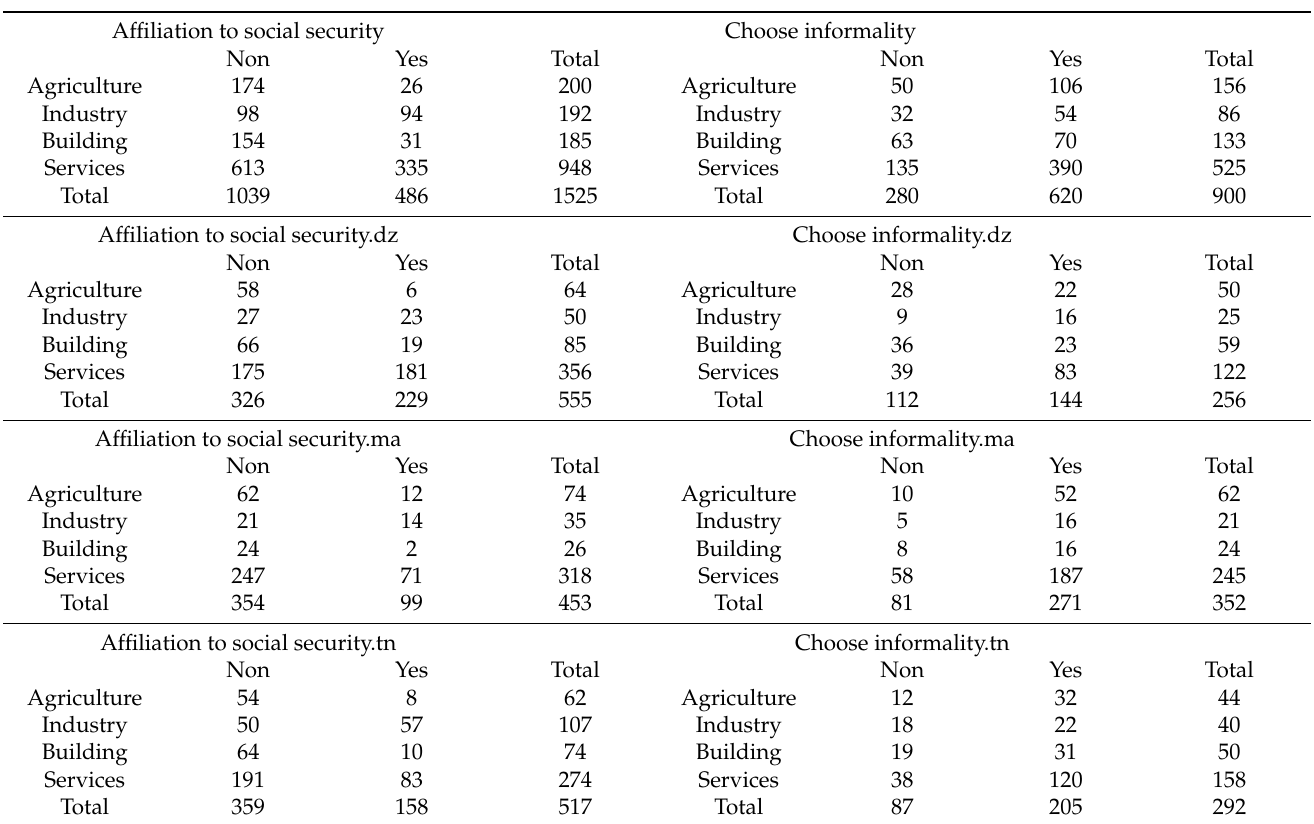
Table A5. Affiliation to social security and the reason for not being insured according to the sector of activity. Source: Sahwa dataset.